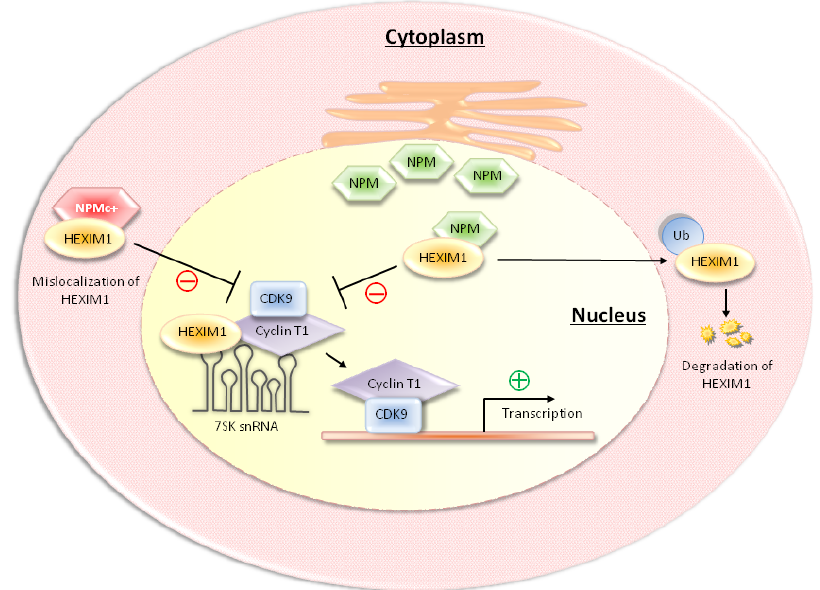
Figure 2. NPM binds to HEXIM1 and mediates the proteasome-dependent degradation of HEXIM1, which favors the release of the small P-TEFb ( i.e ., CDK9/cyclin T1) from the HEXIM1-containing large P-TEFb complexes. The cytoplasmic NPM mutant, NPMc+, associates and misallocates a portion of HEXIM1 in cytoplasm, resulting in decreases in the formation of large P-TEFb complexes and activation of RNAP II